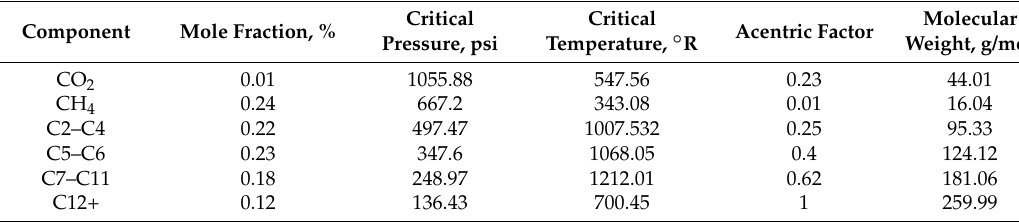
Table 3. Live oil composition and properties.